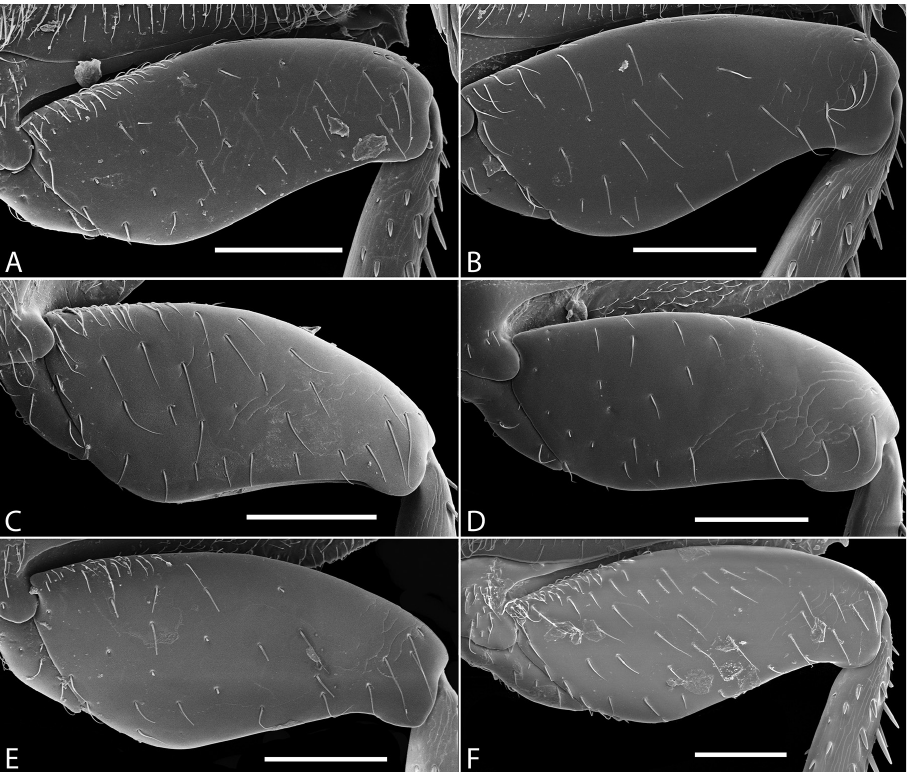
Figure 12. Metafemora (ventral view) of Tobochares spp. A T. kasikasima B T. sipaliwini C T. pallidus sp. n. D T. canthus sp. n. E T. canaliculatus sp. n. F T. striatus. Scale bars = 0.1 mm. (nearly black), with prosternum slightly paler; epipleura, legs, labial palps, and antennae distinctly paler, with antennal club slightly darker than proximal antennal segments. Ground punctation on head, pronotum and elytra moderately fine. Head . Eyes measur- ing ~100µm anteroposteriorly, continuous with outline of head, emarginate at lateral margin, narrowing to about half to slightly greater than half the width. Thorax . Elytra with ten rows of serial punctures which are depressed into shallow grooves in the posteri- or half, with depth of the grooves greatest near the elytral suture (Fig. 11A). Metafemora mostly glabrous on ventral face, with narrow band of pubescence along proximal third of anterior margin (Fig. 12B). Elevation of mesoventrite forming a low transverse carina with an acute “tooth,” elevated to the same plane as the ventral surface of the mesocoxae (Fig. 9E). Metaventrite with distinct median ovoid glabrous area that is more than half of the total metaventrite length, and about half as wide as it is long (Fig. 10E). Abdomen . Abdominal ventrites uniformly and very densely pubescent, with small spicules inter- spersed amongst the setae (e.g. Fig. 13A). Aedeagus (Fig. 14C) with parameres slightly wider than median lobe; parallel sided in basal half, then slightly narrowing in apical half to third; apex of parameres very slightly expanded and bluntly rounded. Median